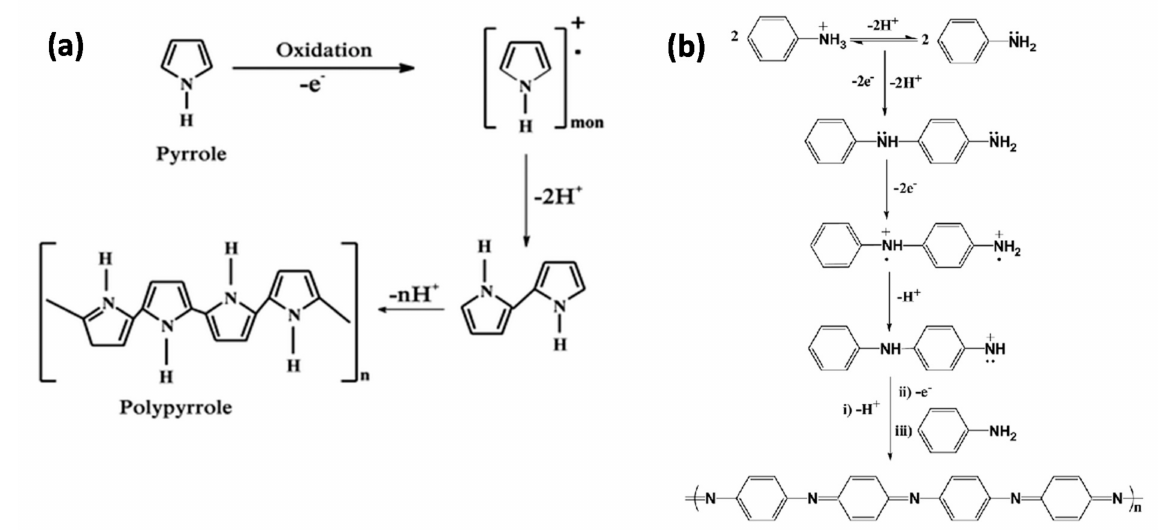
Figure 4. Simple pathways for the synthesis of polypyrrole ( a ) and polyaniline ( b ). Figure 4b is reproduced from [48] with the permission of Elsevier.